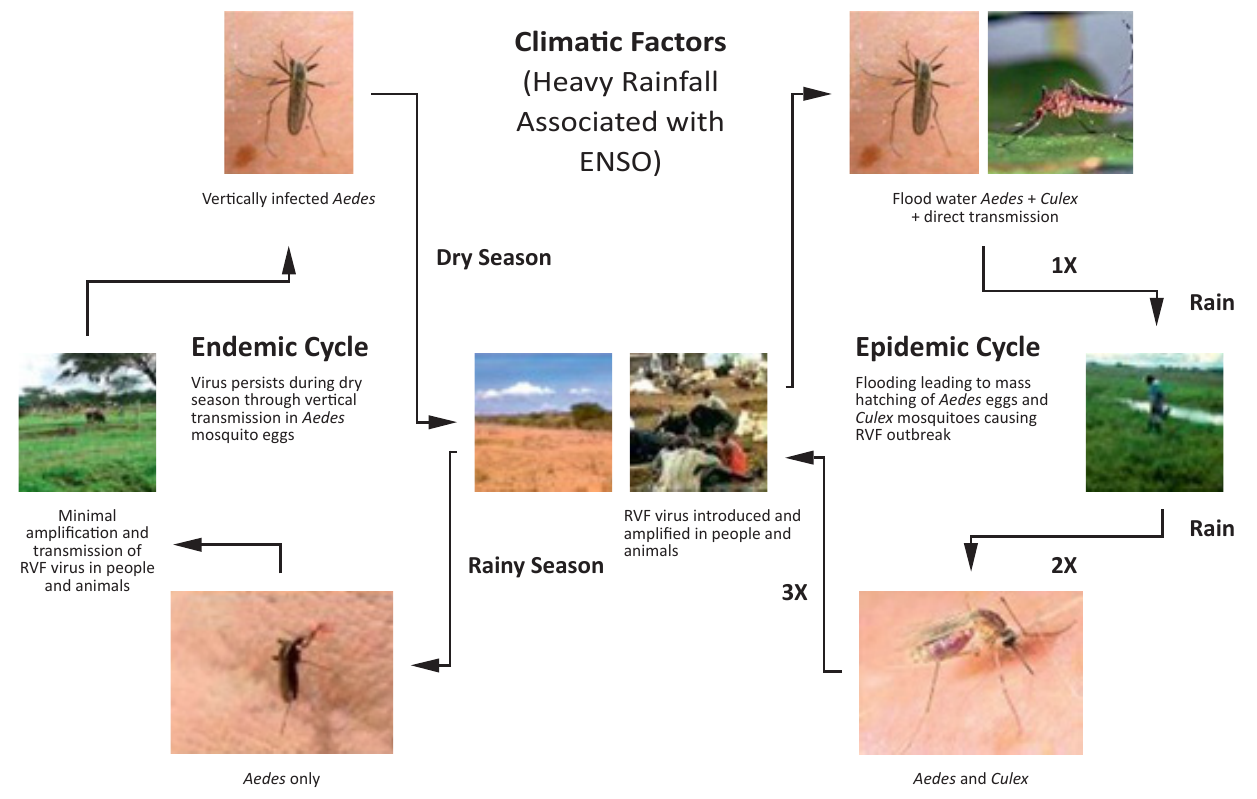
FIGURE 3: Endemic (on left) and epidemic (on right) life cycles of Rift Valley fever involving close association between heavy rainfall conditions, vector Aedes and Culex mosquitoes, domestic animals and humans.